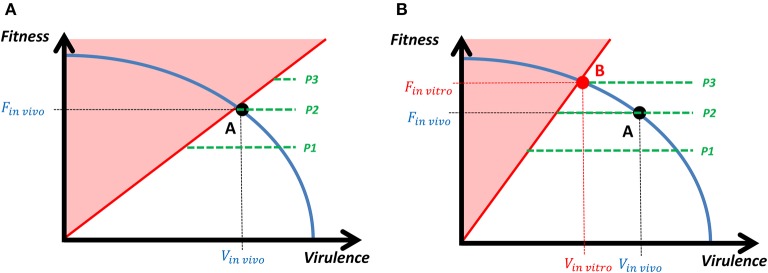
Transition from in vivo to in vitro equilibrium. The tradeoff between fitness and virulence is represented by the downward sloping efficient frontier (blue line), and the green dotted lines represent the indifference curves. Each indifference curve represents the combination of fitness and virulence that provide the same payoff to the bacteria and we assume that the payoff landscape is independent on the virulence and increasing on fitness, which determines the form of the indifference curves (P1 < P2 < P3). (A) When facing the in vivo conditions (intra- and extracellular defense systems are adopted by the host) the payoff of the bacterium in the red zones is equal to zero (if the bacteria are too virulent, they will kill the host along with the bacteria themselves; if the bacteria are not virulent enough relative to their fitness, they will be easily detected by the host's immune system and eliminated), and the optimal strategy for the bacterium is characterized by the tangency point between the highest indifference curve and the efficient frontier (point A). (B) When moving to the in vitro conditions (only intracellular defense system is adopted by the host), the zone for which the bacterium's payoff is reduced, so the equilibrium changes (point B) and the bacterium achieves a higher payoff (P3 > P2). However, when the bacterium faces back the in vivo conditions, the equilibrium point B gets into the red zone. This means that the bacteria are not virulent enough (relative to their fitness) to evade the host's immune system and they are eliminated.